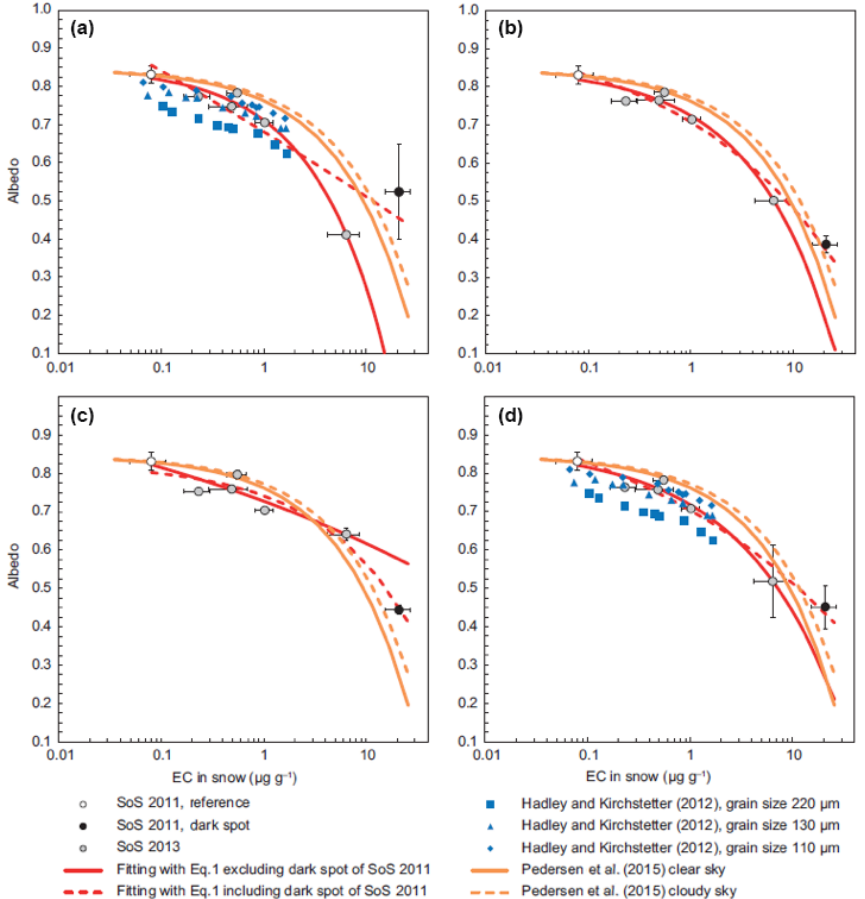
Figure 10. Broadband albedos at noon on SoS days 1–3 as a function of the EC concentration in the surface layer: (a) day 1, (b) day 2, (b) day 3, and (d) days 1–3. In all plots, the SoS 2011 reference albedo is the average over solar noon albedo during the first week of the experiment. In (a) – (c) , the gray and black circles are 60min albedo averages at solar noon, and the vertical and horizontal bars are standard deviations for albedo and EC, respectively. In (d) , the circles are the albedo averages at solar noon on days 1–3, and the vertical and horizontal bars are standard deviations for albedo and EC, respectively (Svensson et al., 2016).